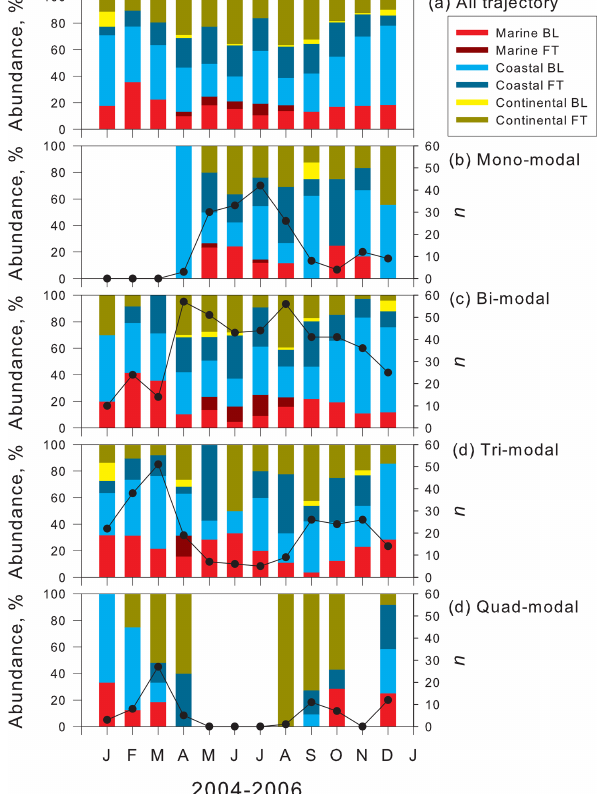
Figure 5. Seasonal feature of air mass origins of (a) all trajec- tory, (b) mono-modal structure, (c) bi-modal structure, (d) tri-modal structure, and (e) quad-modal structure at Syowa Station, Antarc- tica. Black line, black circles, and “ n ” represent the number of the appearance of each modal structure.